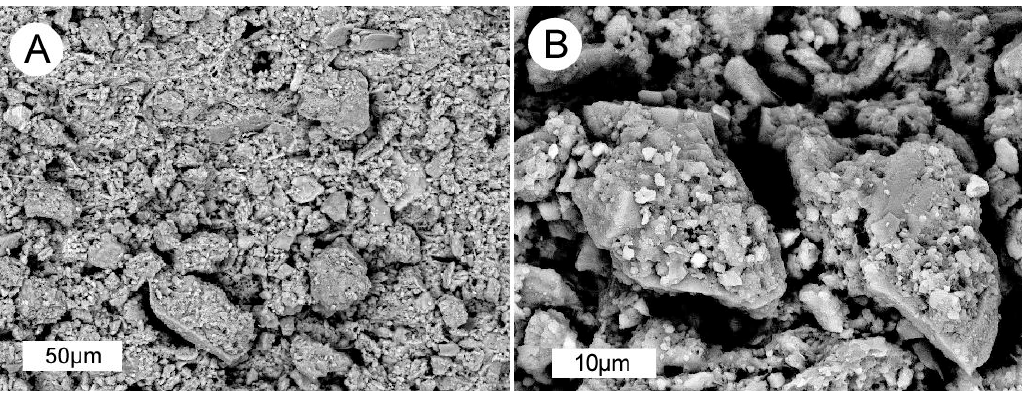
Figure 15. SEM images of siliceous silty shale. ( A ) Poorly sorted fine-grained sediment. ( B ) Note the porosity caused by interstitial spaces, and the encrustation of clast surfaces as a result of diagenesis.